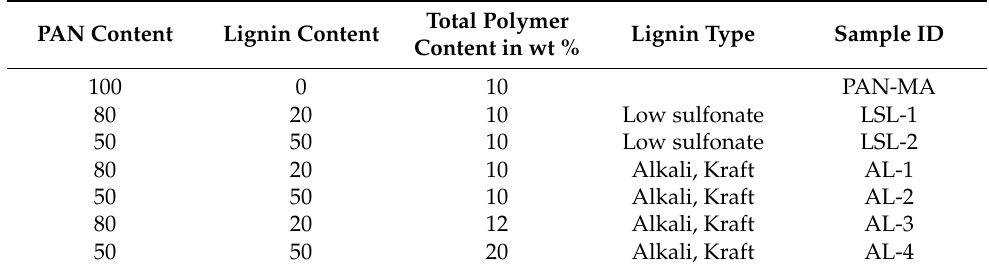
Table 1. Weight ratios of PAN-MA:Lignin polymer blends prepared based on total polymer concen- tration in wt